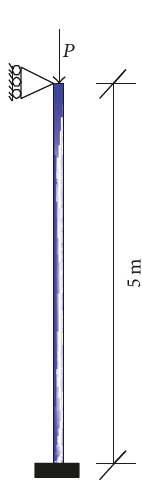
Figure 3: Reliability index with respect to ultimate strength (𝐹 𝑢 ) for Example 1.